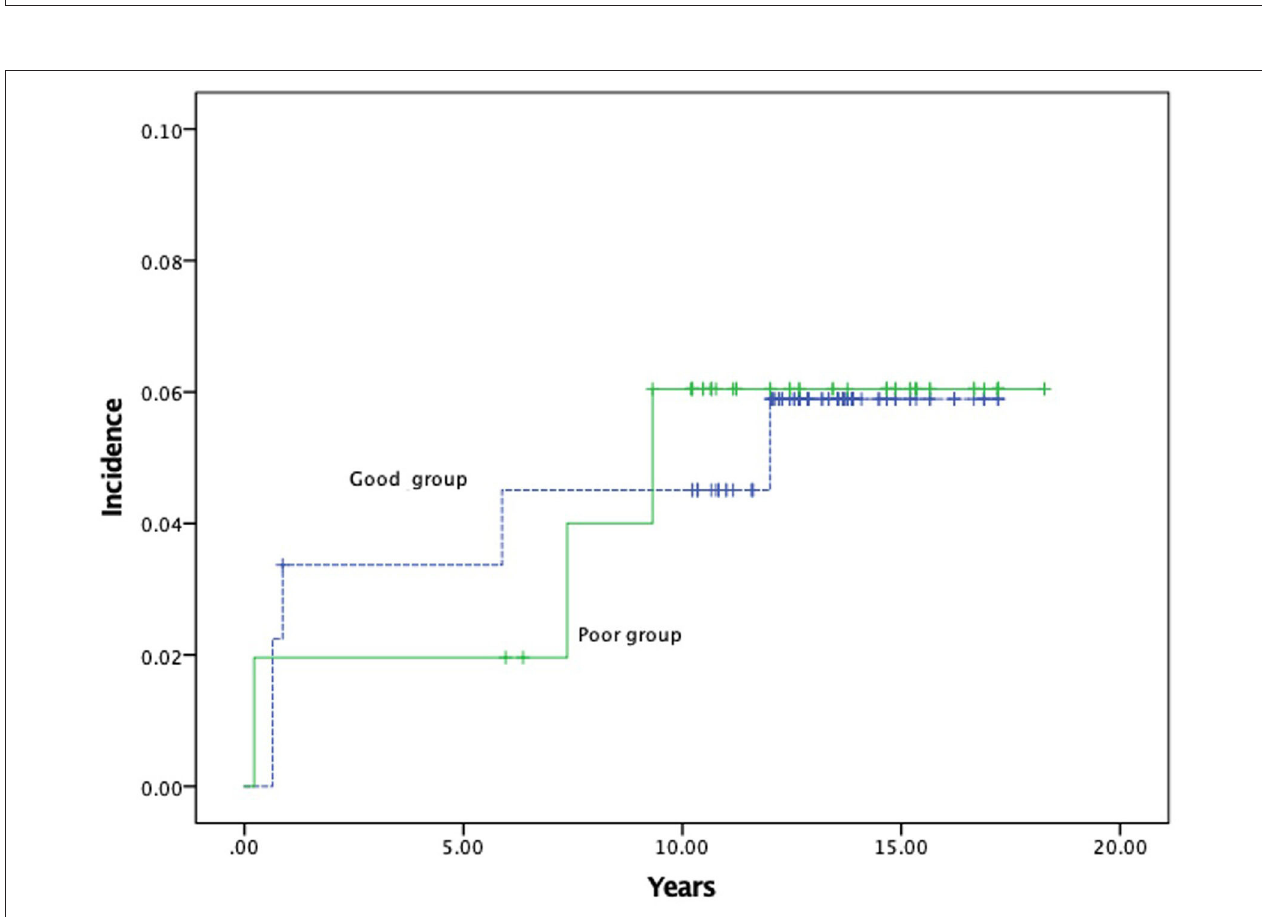
FIGURE 4 | The Kaplan–Meier curves for stroke events between good and poor postoperative collateral circulation group during long-term follow-up.